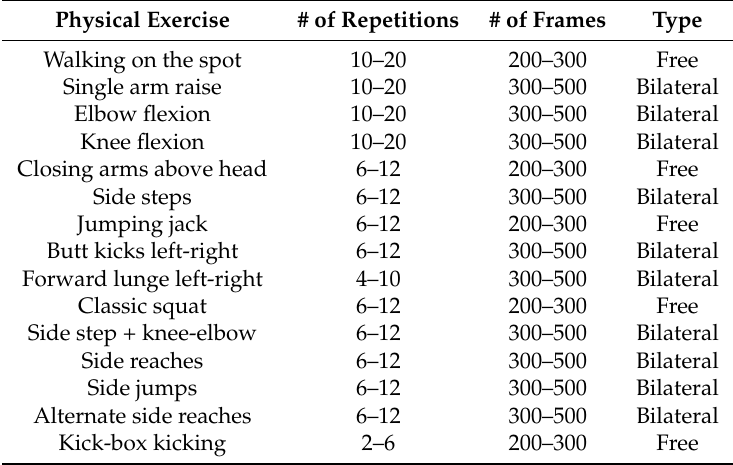
Table 1. Data captured per subject in the DMC3D